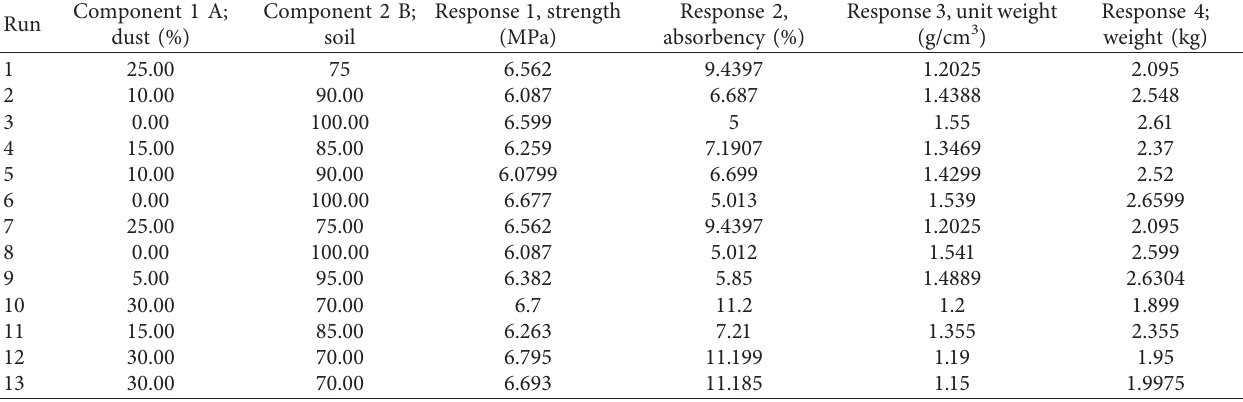
Table 4: Experimental test results for compressive strength, water absorption, and mass and unit weight of